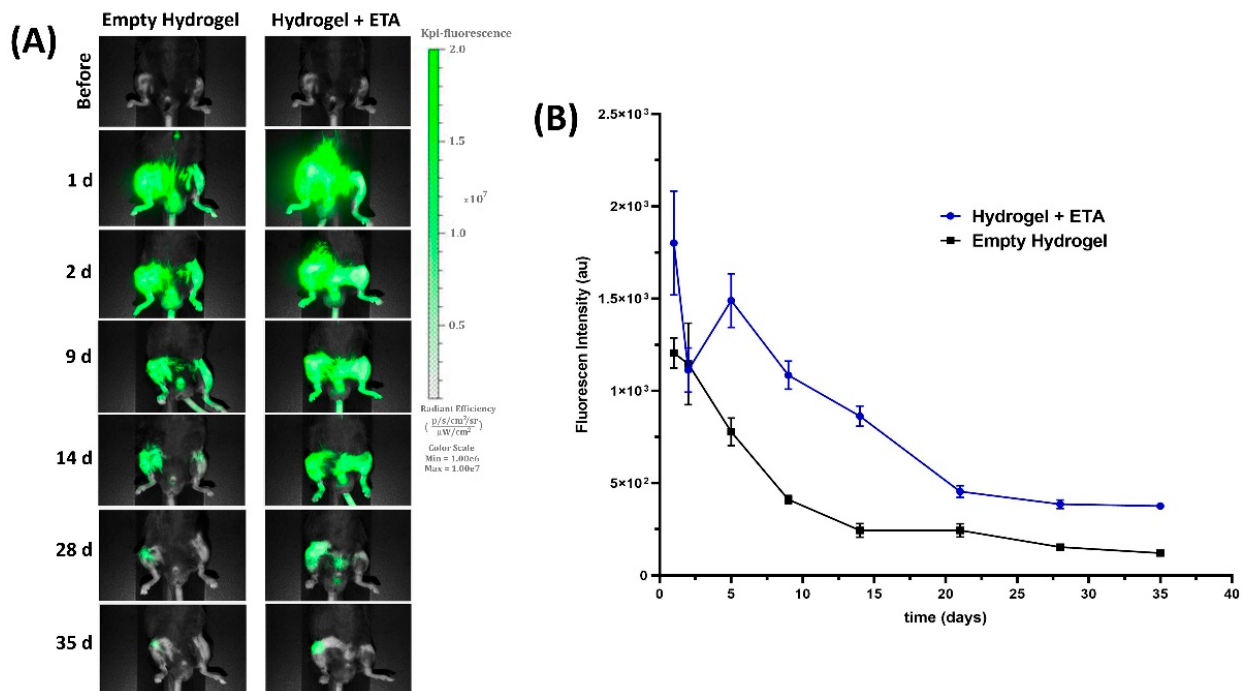
Figure 5. Mice knee images after hydrogels injection ( A ) NIR fluorescence imaging of mice knee joints taken at different time points after intra-articular injection of empty and ETA-loaded hydrogels containing NIR-780. ( B ) Graph depicting the decrease of fluorescence intensity after injection over the duration of the experiment. Data are presented as mean ± SD ( n = 6).